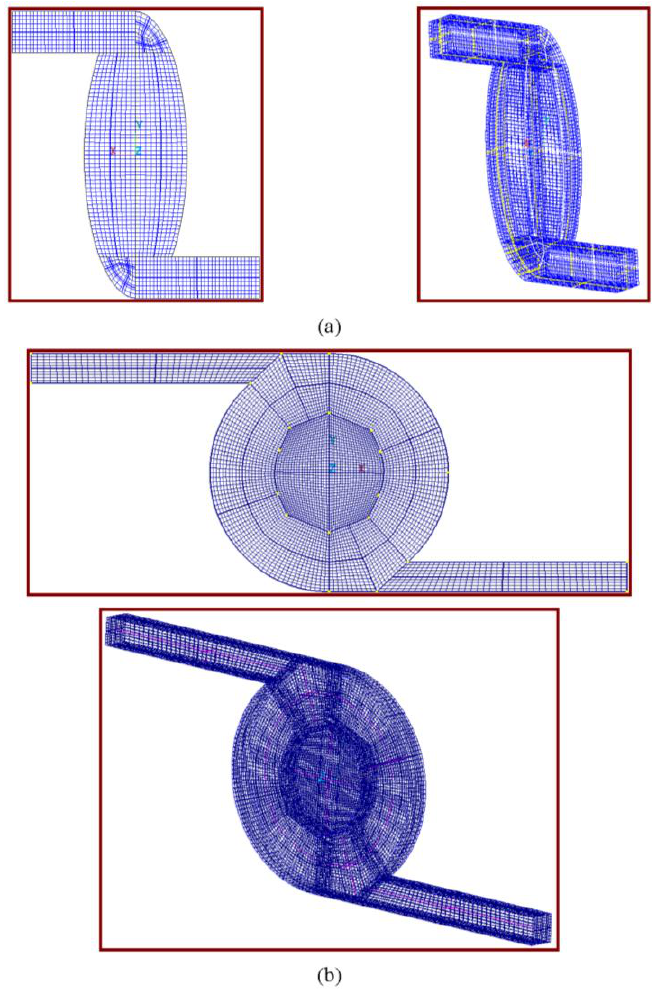
Figure 2. The grid systems of the computation domain for ( a ) oval and ( b ) circle disk-shaped